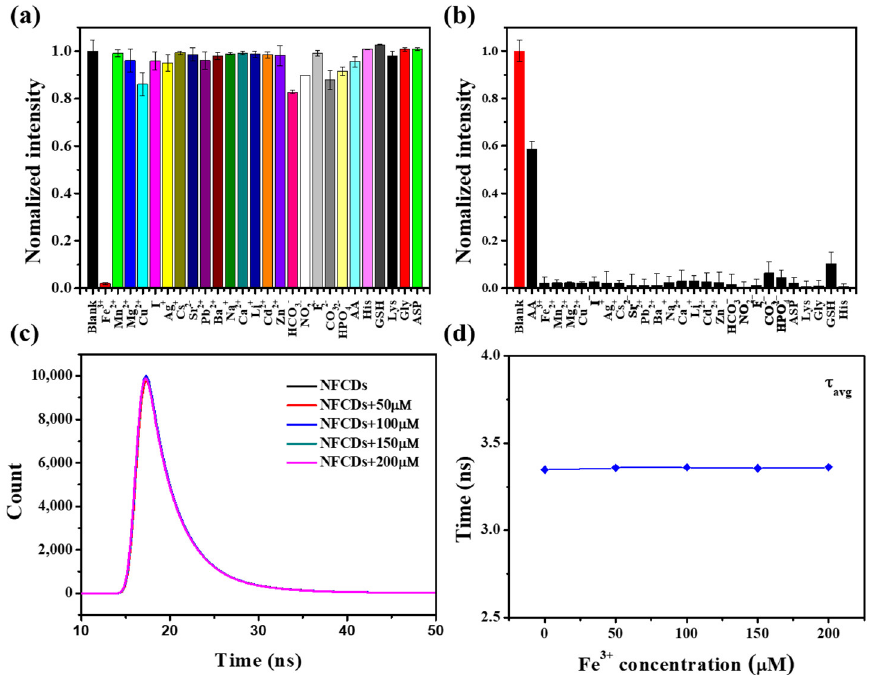
Figure 5. ( a ) Fluorescence intensity of NFCDs in the presence of different ions and amino acids (con- centration: 1 mM). ( b ) Fluorescence intensity of NFCDs after adding different ions and amino acids into the reaction system containing Fe 3+ and NFCDs (concentration: 1 mM). ( c ) Fluorescence lifetime spectrum and ( d ) fitting diagram of NFCDs (0.1 mg mL −1 ) with different concentrations of Fe 3+ .